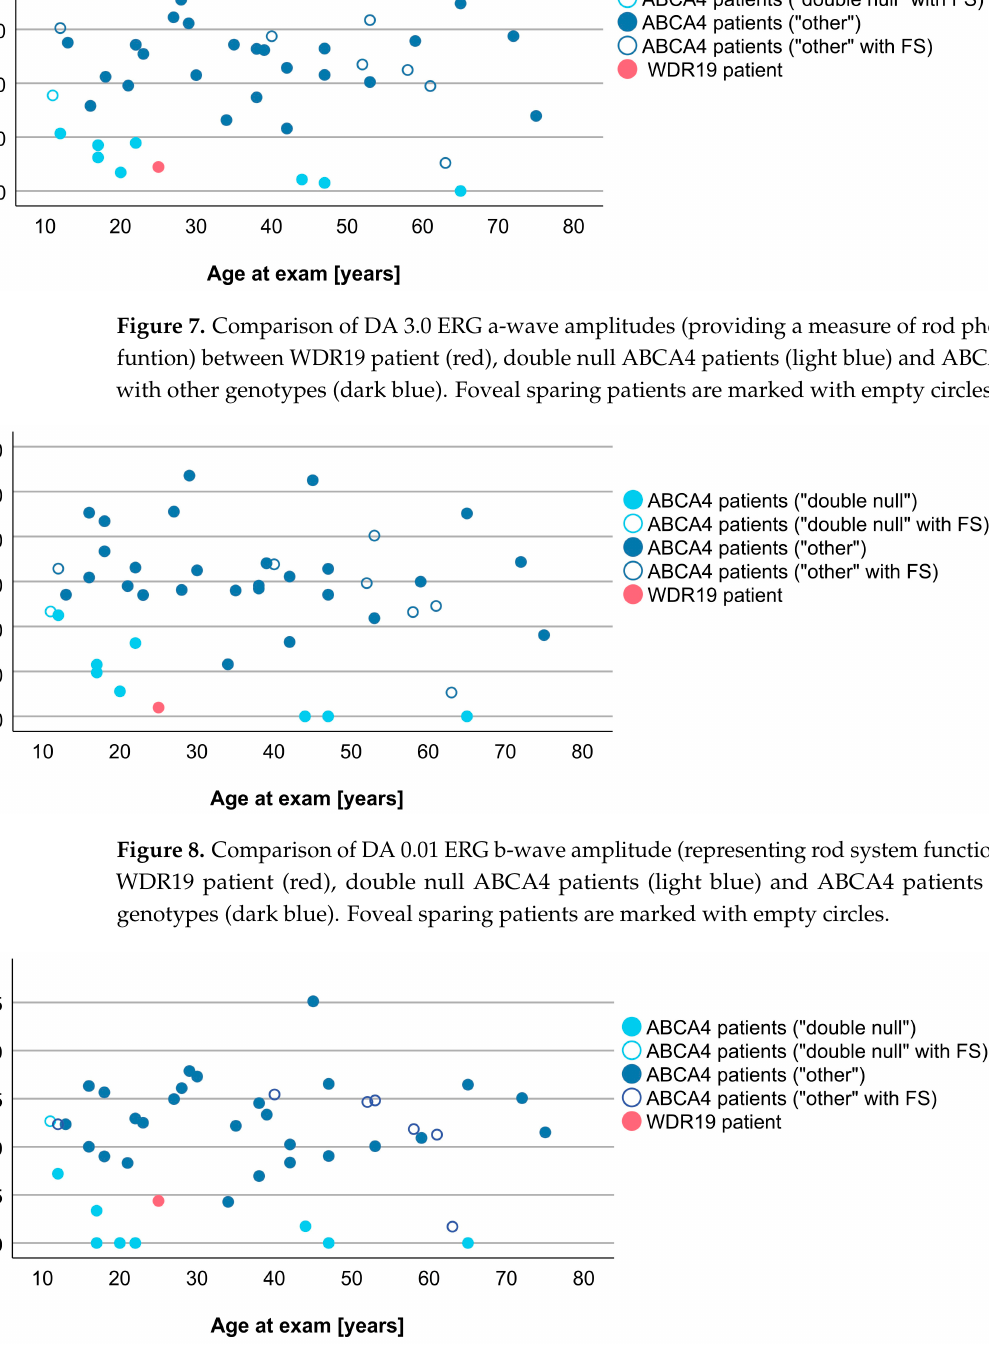
Figure 9. Comparison of LA 30 Hz ERG amplitudes (representing cone system function) between WDR19 patient (red), double null ABCA4 patients (light blue) and ABCA4 patients with other genotypes (dark blue). Foveal sparing patients are marked with empty circles.